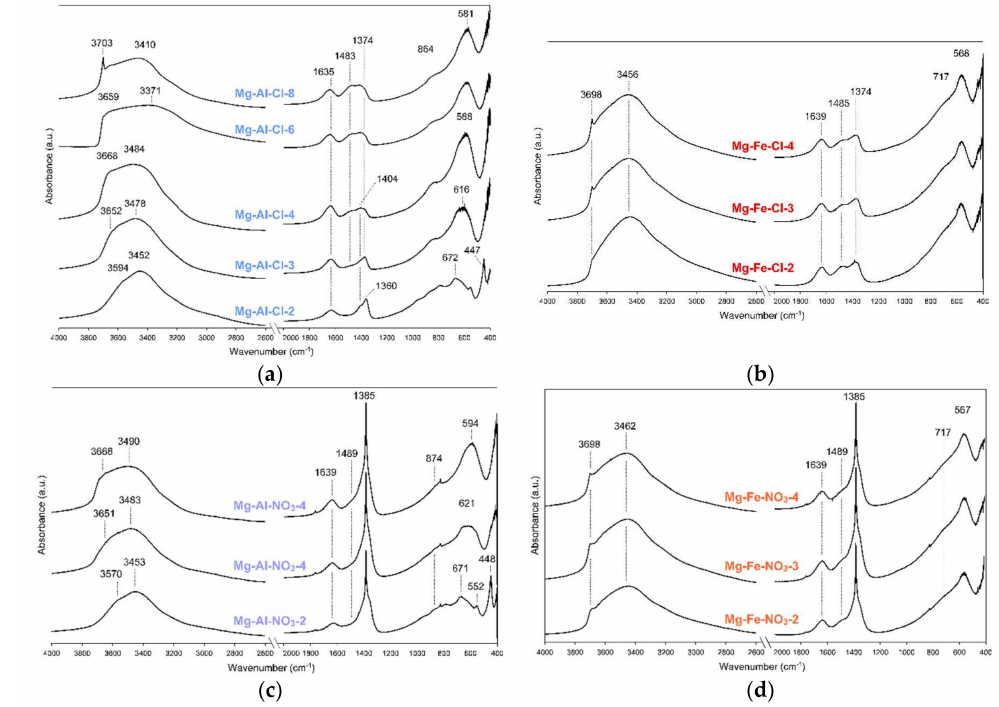
Figure 3. FTIR spectra of raw LDH materials: ( a ) Mg-Al-Cl, ( b ) Mg-Fe-Cl, ( c ) Mg-Al-NO 3 and ( d ) Mg-Fe-NO 3